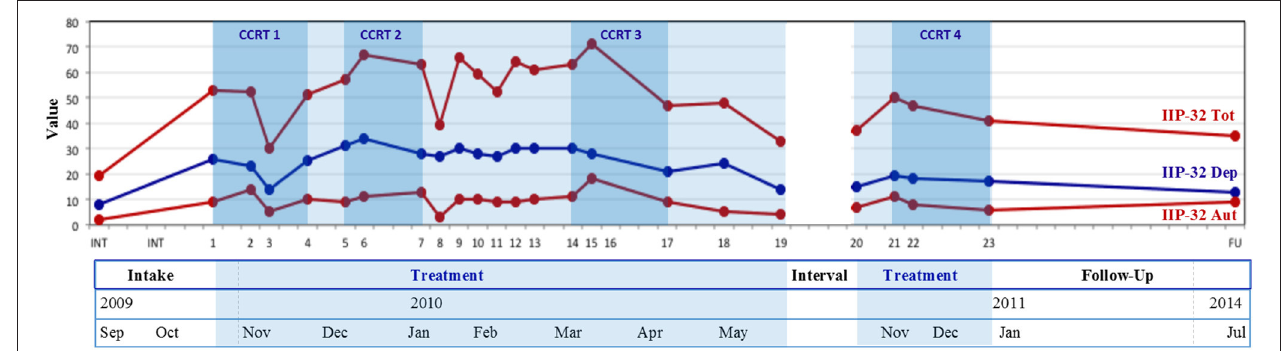
FIGURE 3 | Evolutions in patient-reported interpersonal problems from intake to follow-up. IIP-32 total, Inventory of Interpersonal Problems-32 total scores; IIP-32 Dep, Inventory of Interpersonal Problems-32 subscores dependency; IIP-32 Aut, Inventory of Interpersonal Problems-32 subscores autonomy; CCRT1, Conflictual Relationship Theme codings of therapy sessions 1–4; CCRT2, Conflictual Relationship Theme codings of Tipping point 1 sessions; CCRT3, Conflictual Relationship Theme codings of Tipping point 2 sessions; CCRT4, Conflictual Relationship Theme codings of last three sessions. Treatment was interrupted between sessions 19 and